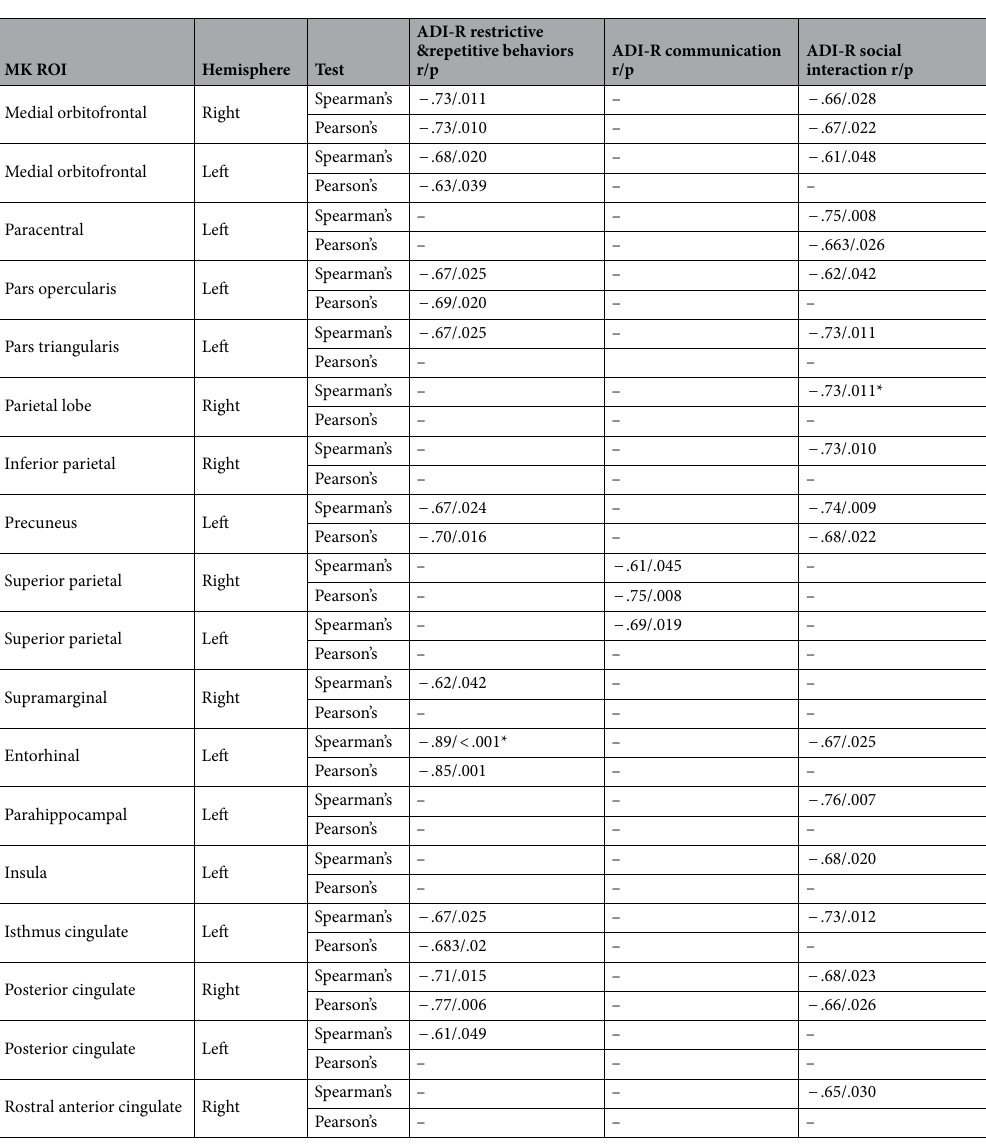
Table 3. Spearman’s and Pearson’s correlations assessing associations between MK and lifetime clinical symptoms as measured by ADI-R. A higher score on the ADI-R indicates increased severity. All tests shown reached trend-level at p ≤ 0.05, uncorrected. Tests that remain significant after the Benjamini–Hochberg correction for multiple comparisons are indicated by an asterisk (*) (q ≤ .05 BH FDR).